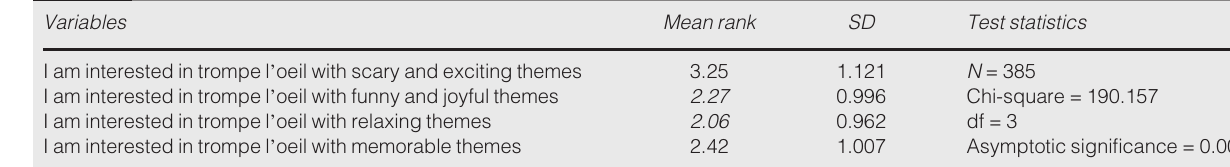
Table 4 The output of the Friedman test for the investigation of priority of emotional themes for trompe l ’ oeil from the tourists ’ perspective